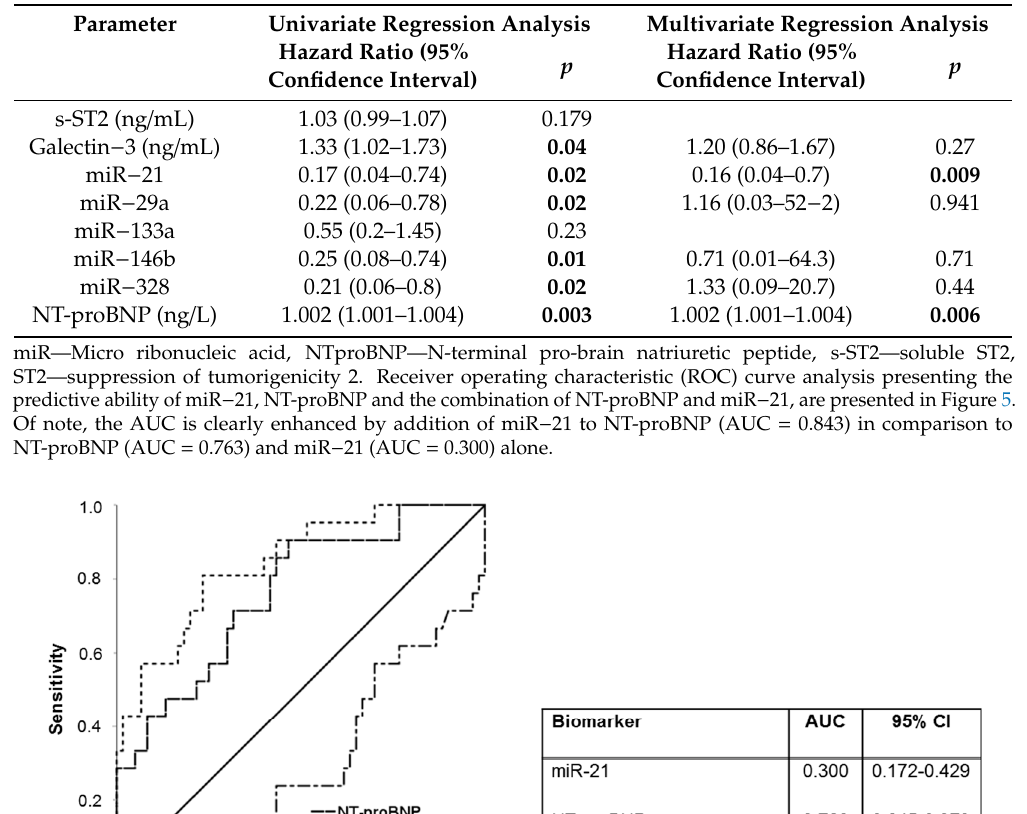
(cid:80) n = 81, AF n = 21).